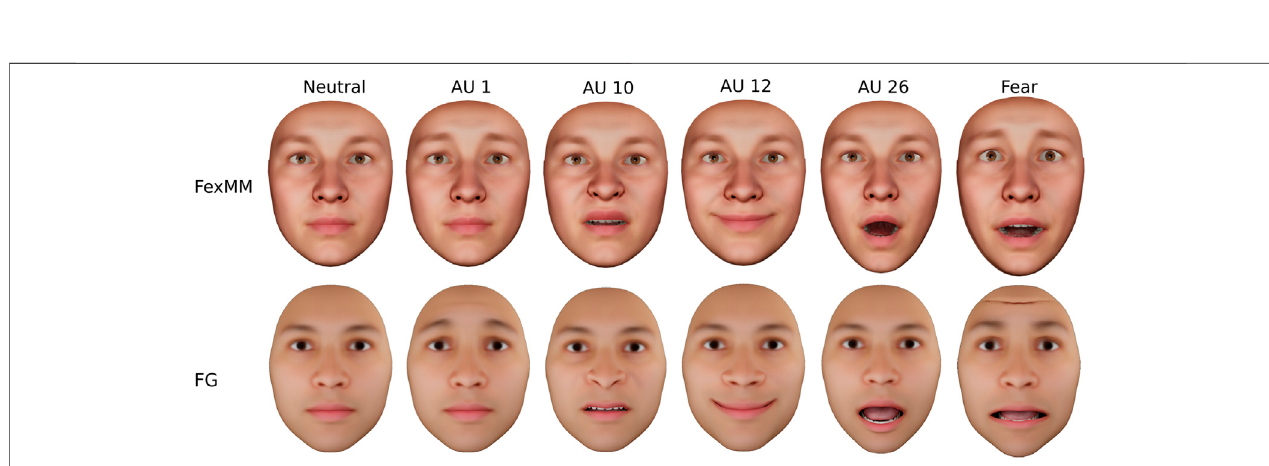
FIGURE 2 | Comparison of AU activations between the FexMM and FG expression models. Artifacts arise for combination of multiple AUs in the designed FG model, like the folding on the forehead in fear illustrated on the right.